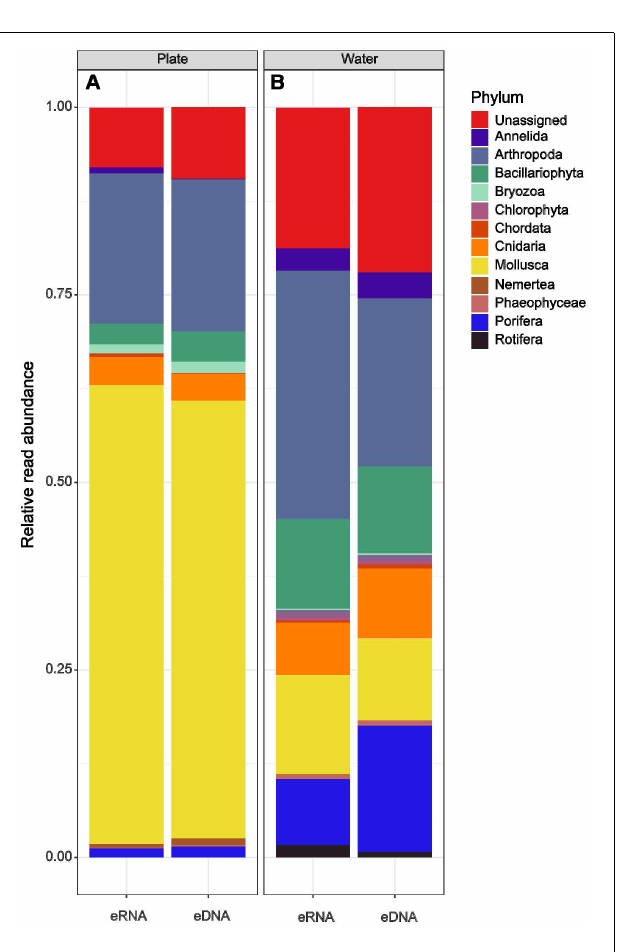
FIGURE 4 | Percentage bar plots showing the relative abundance of sequence reads at the phylum level from environmental RNA and DNA metabarcoding data for plate and water